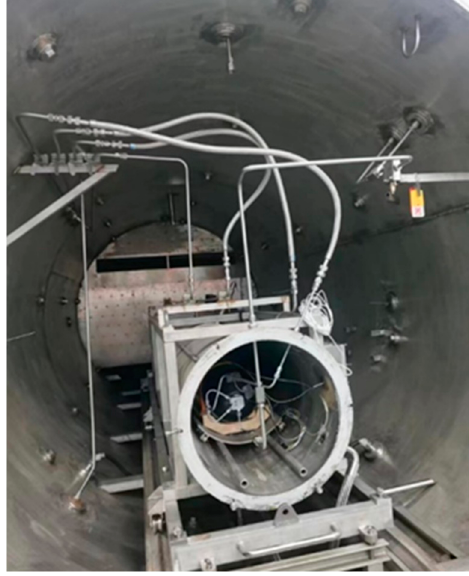
Figure 3. Experimental device and installation positions of the cylinders.